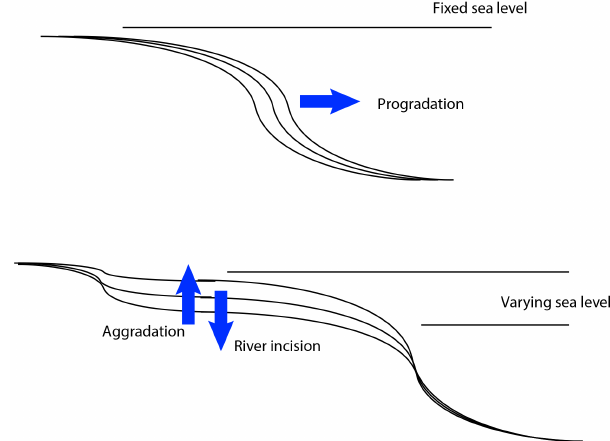
Figure 3. Simple scheme of the two different geomorphological dynamics considered here. (top) With small sea level changes, we assume that the dominant sedimentary regime is progradation, with rather small organic carbon burial in coastal areas. The net effect of precessional forcing is (old) soil erosion, therefore a net trans- fer of carbon to the ocean–atmosphere. (bottom) With large sea level changes during the late Quaternary, the dominant sedimen- tary regime can switch temporarily to aggradation just after major sea level drops and river incisions. During these transitory phases, the net effect of precessional forcing is reversed, with net organic carbon burial in river beds and river